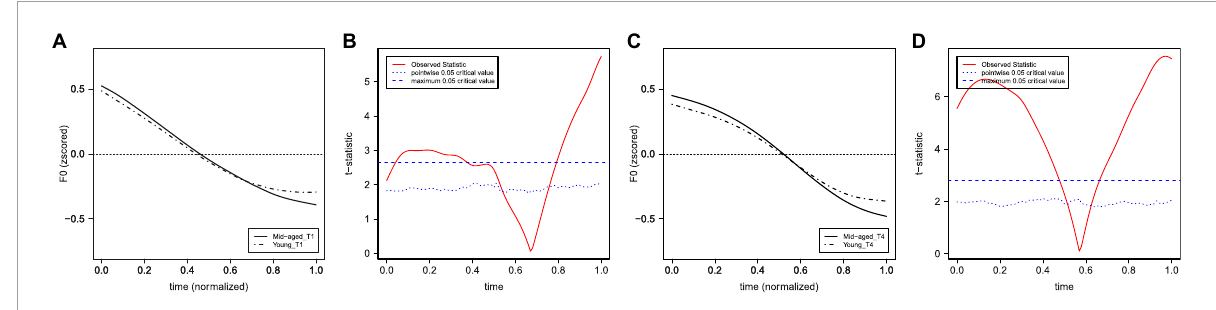
FIGURE7 The average of the (normalized) F0 curves between the middle-aged and young participants for T1 (A) and T4 (C) and their functional t -test statistics in panels (B,D) . The solid lines represent the F0 curves of middle-aged participants, and the dot-dash lines represent the F0 curves of young participants.